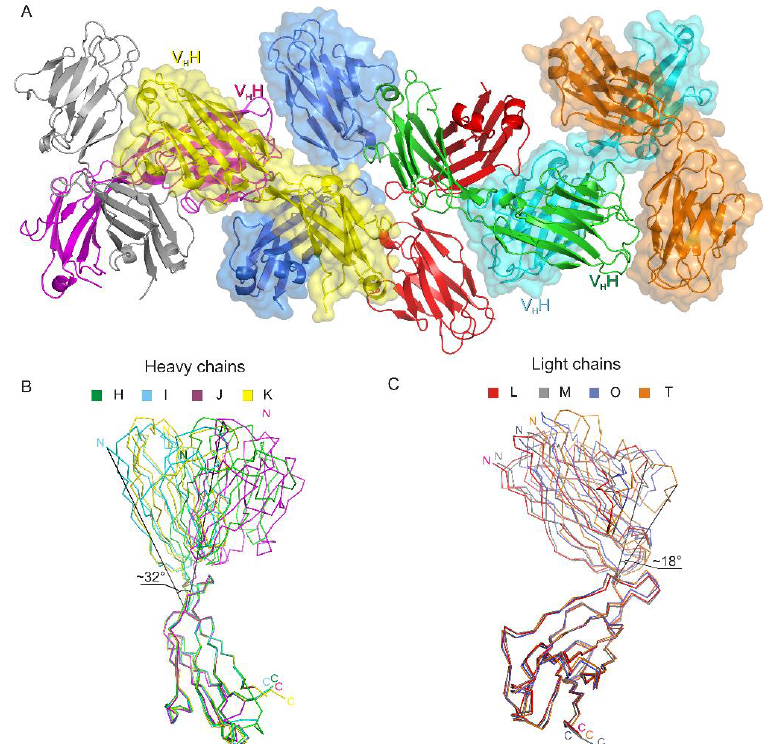
Figure 2. The crystal packing of the netakimab Fab fragment. ( A ) Crystal packing of the four Fab fragment molecules in the asymmetric unit. Heavy and light chains are indicated with different colors, surfaces of even molecules are colored. ( B ) Structural alignment of the different conformations obtained for the heavy chains (H, I, J, K). ( C ) Structural alignment of the different conformations obtained for the light chains. Extreme fluctuation angles for variable domains relatively to constant domains are indicated (the angle vertices are at the last matching Cα atoms of the main chains).